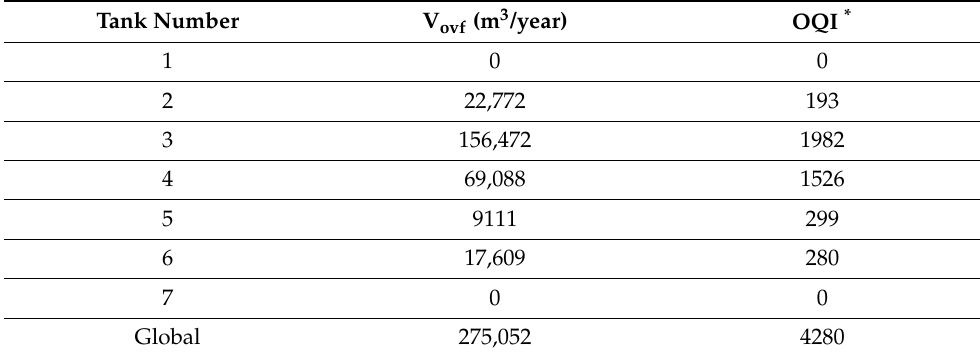
Table 12. Simulation results when the overflow quality index is minimized (strategy #3).